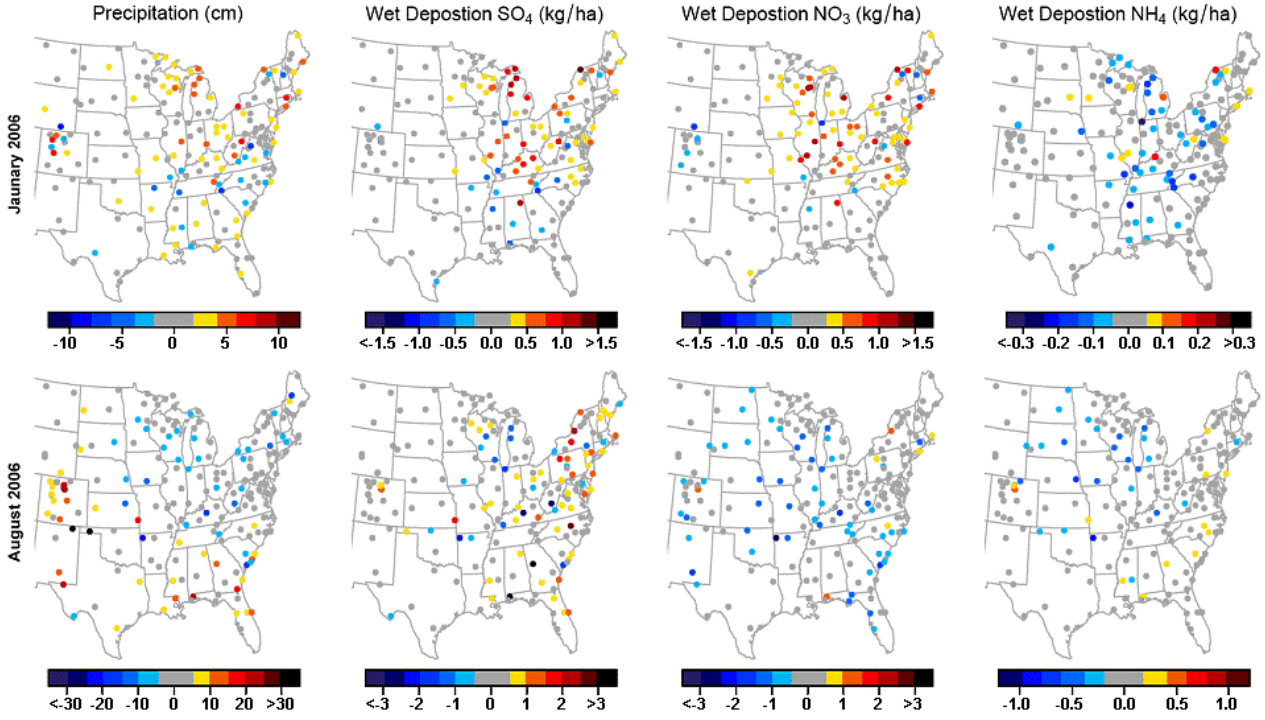
Fig. 12. Difference in monthly total precipitation (cm), wet deposition SO 2 − (kg/ha) between the CMAQv4.7 model values and the NADP observations for January (top row) and August (bottom row). January totals are for 3–31 January; August totals are for 1–29 August 2006.